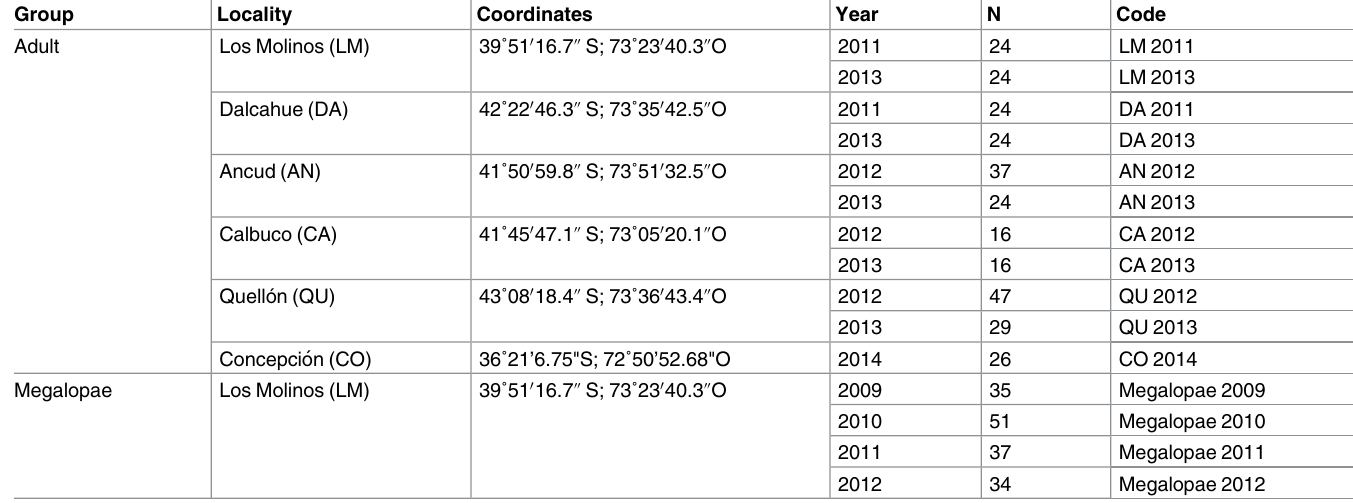
Table 1. Sample size by site and year. Group